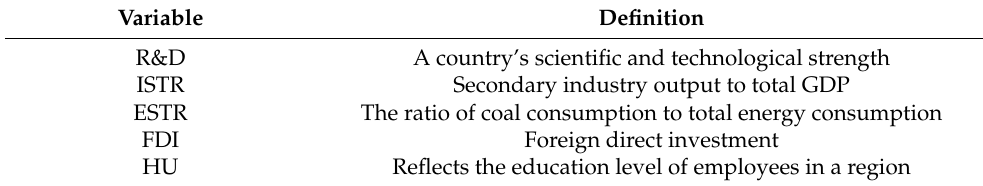
Table 3. Description of independent